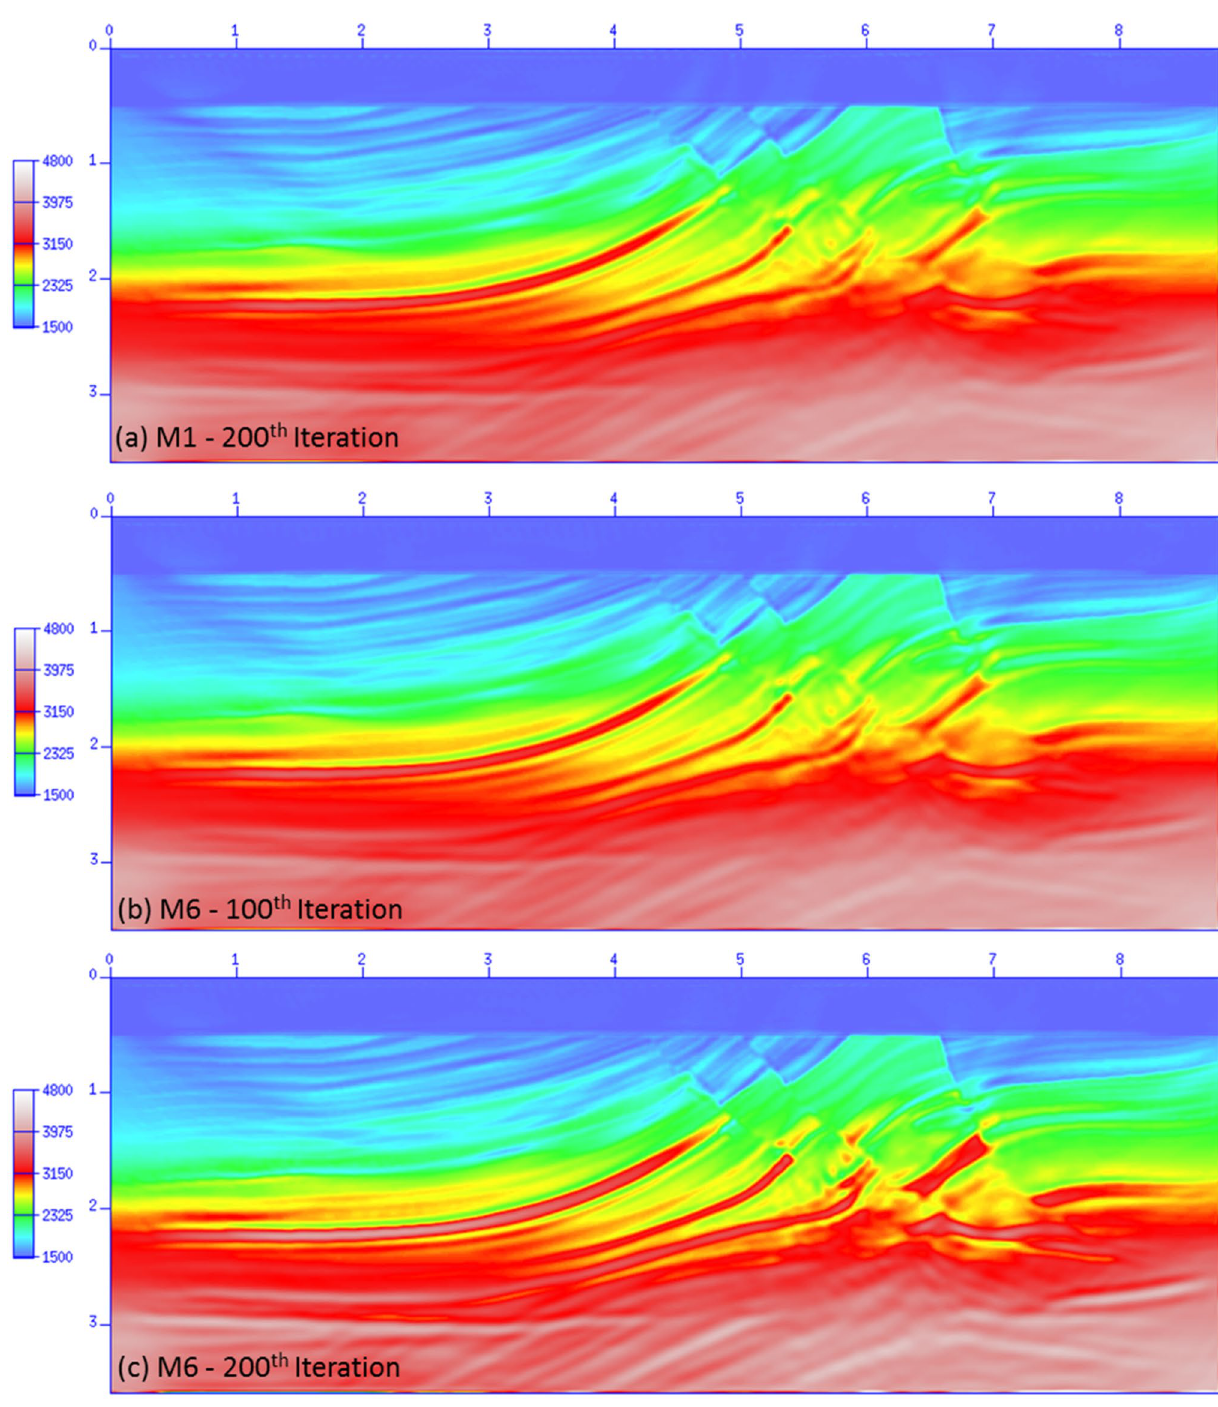
Fig. 9 Inverted Velocity Model from M1 at the 100th iteration ( a) M6 at the 100th iteration ( b ) M6 at the 200th iteration ( c ). M6 is able to invert the model with similar quality in half of the iterations and provide a superior velocity model as compared to